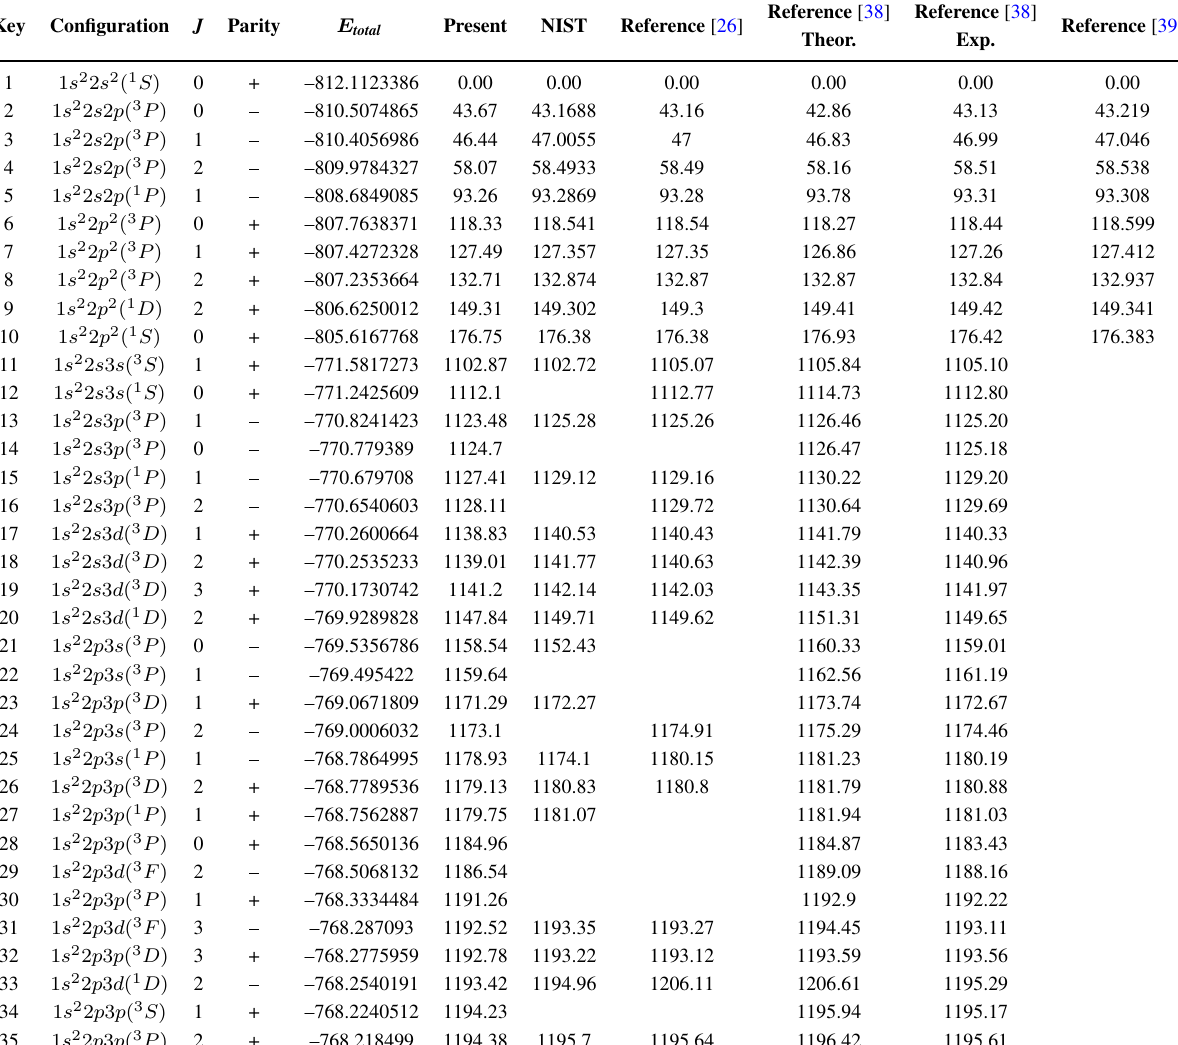
Table 2. Total energies E (in a.u.) and energy levels (in eV) of Be-like iron (Fe 22+ total